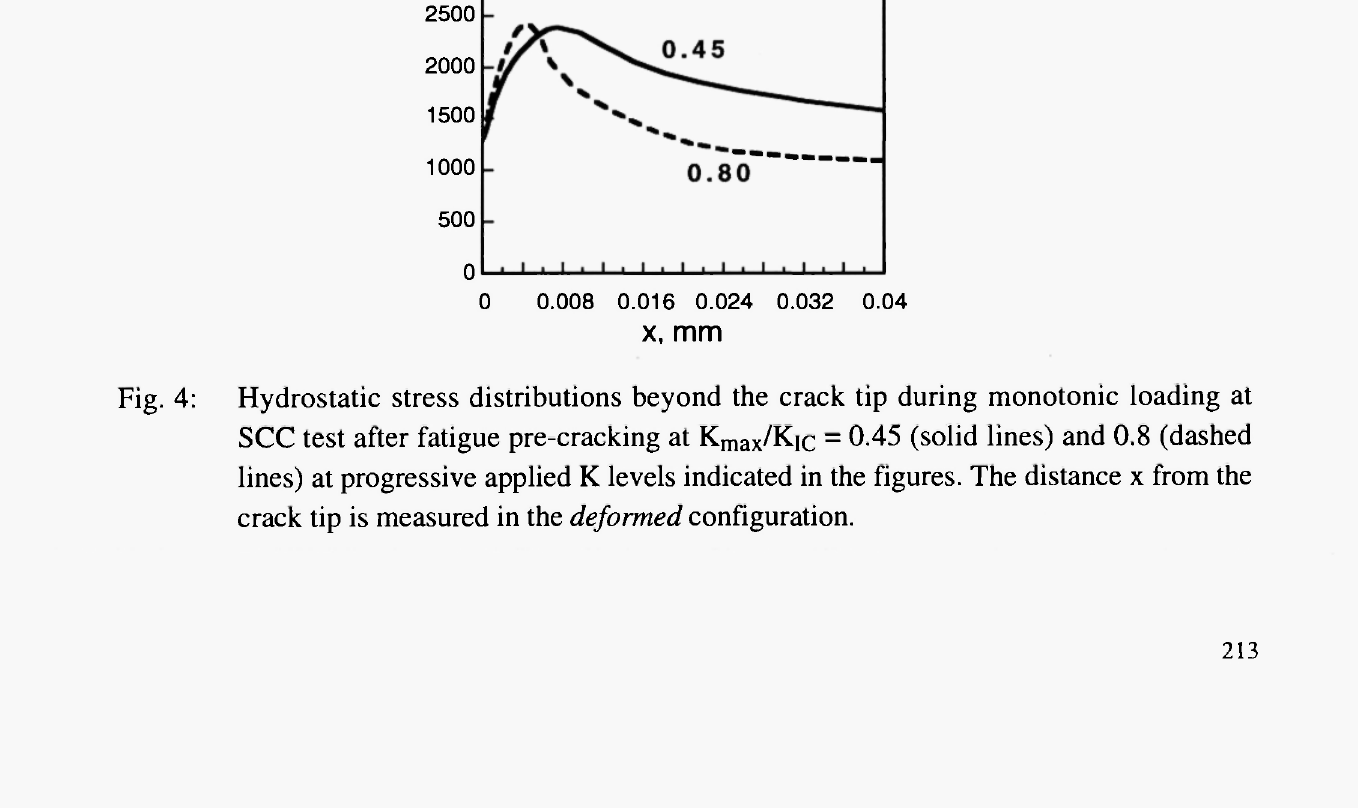
Fig. 4: Hydrostatic stress distributions beyond the crack tip during monotonic loading at SCC test after fatigue pre-cracking at K lines) at progressive applied Κ levels indicated in the figures. The distance χ from the crack tip is measured in the deformed